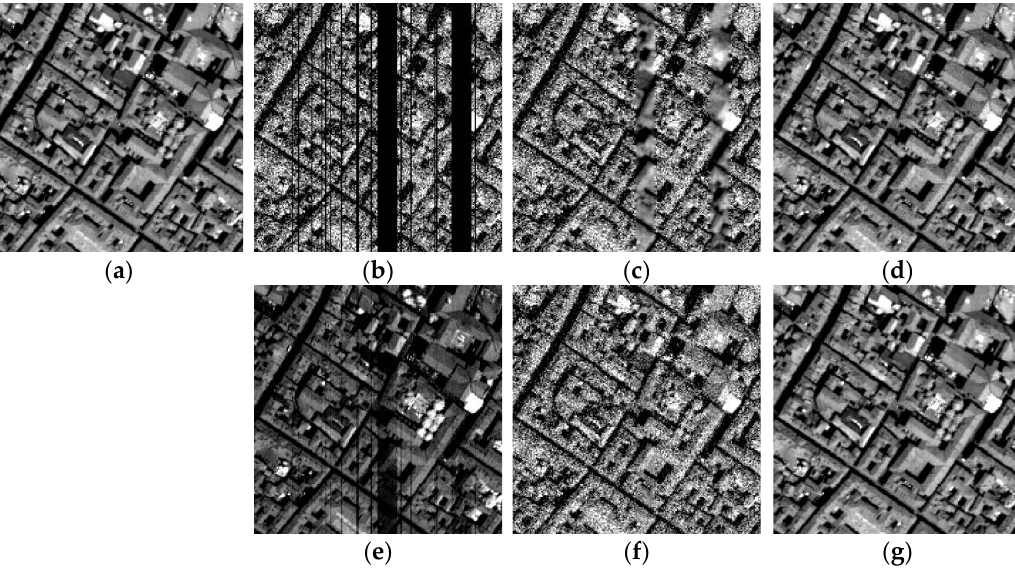
Figure 3. Inpainting results of band 60 of Pavia Centre dataset with Gaussian non-i.i.d. noise. ( a ) Clean image; ( b ) noisy image; ( c ) PDE; ( d ) UBD; ( e ) LLRSSTV; ( f ) BPFA; and ( g )